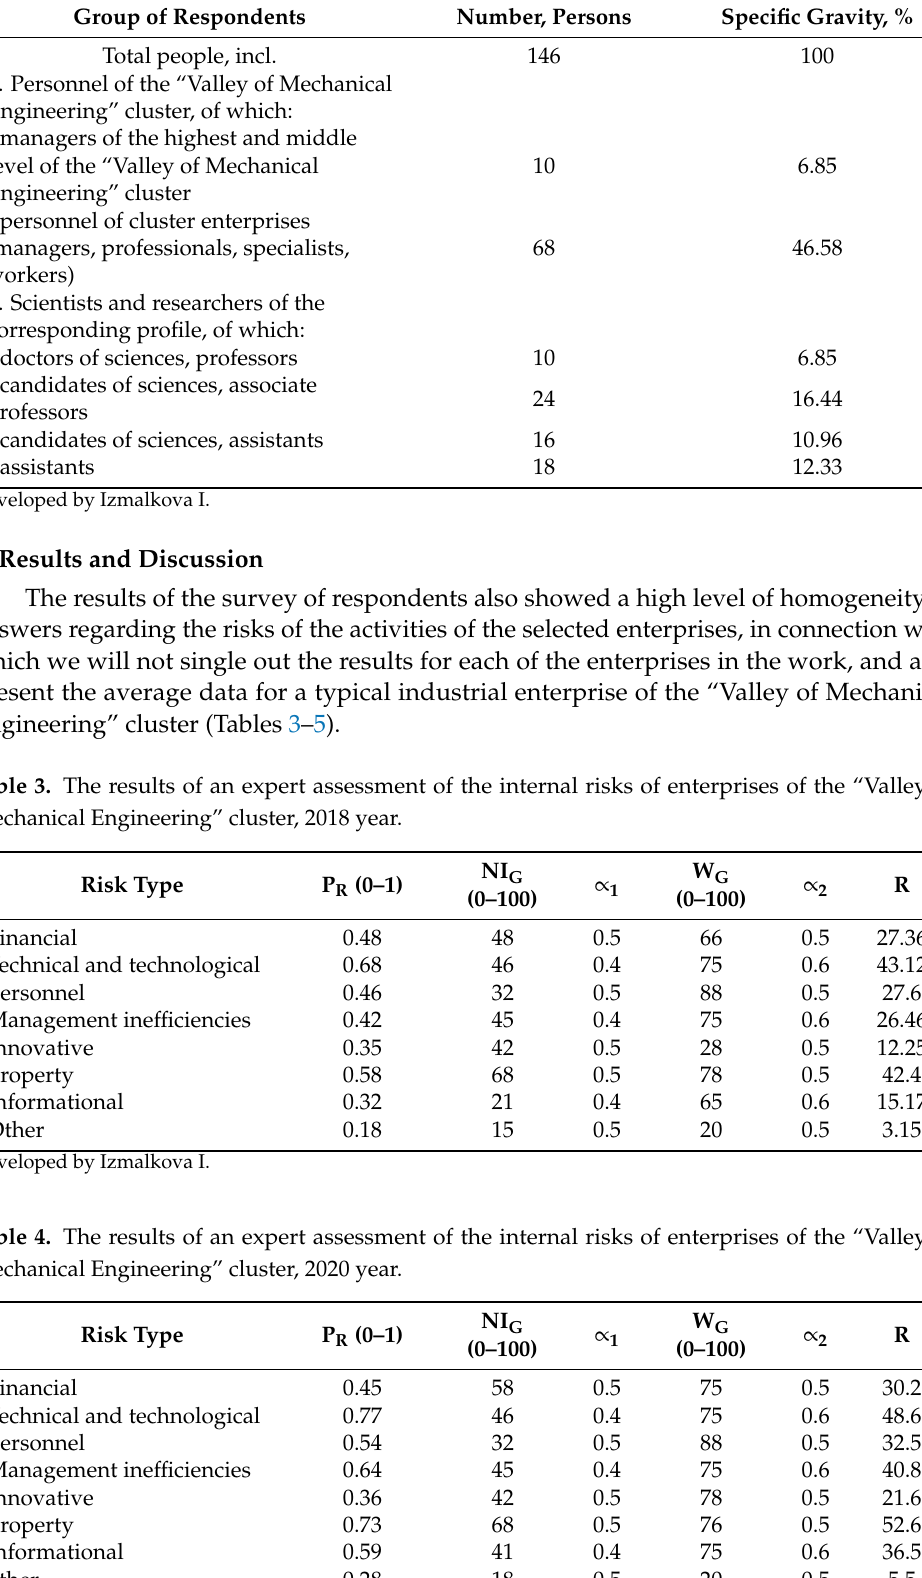
Table 2. Quantitative and qualitative composition of respondents.